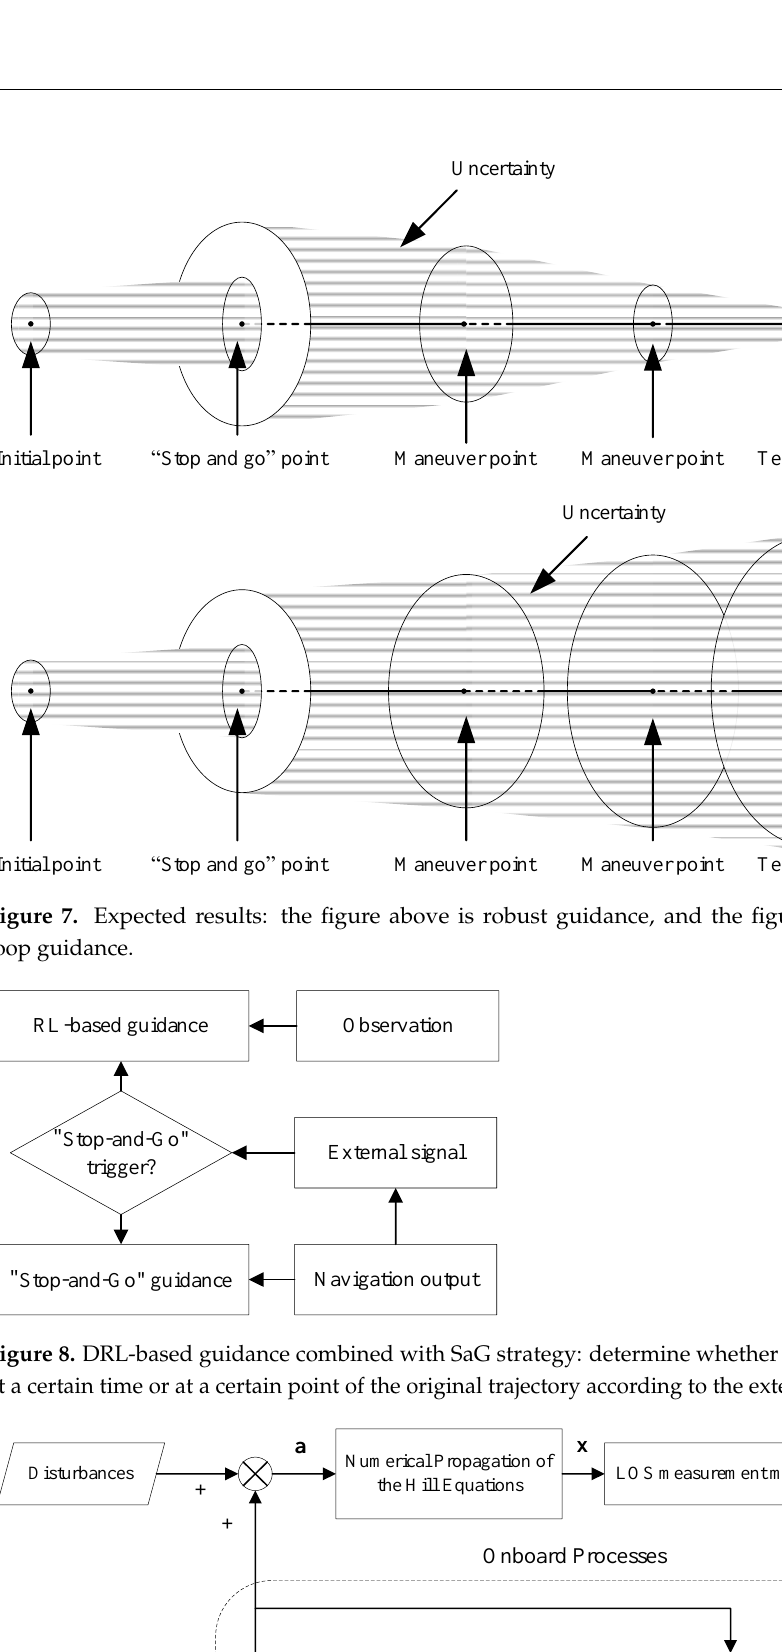
Figure 8. DRL-based guidance combined with SaG strategy: determine whether to insert SaG point at a certain time or at a certain point of the original trajectory according to the external trigger signal.